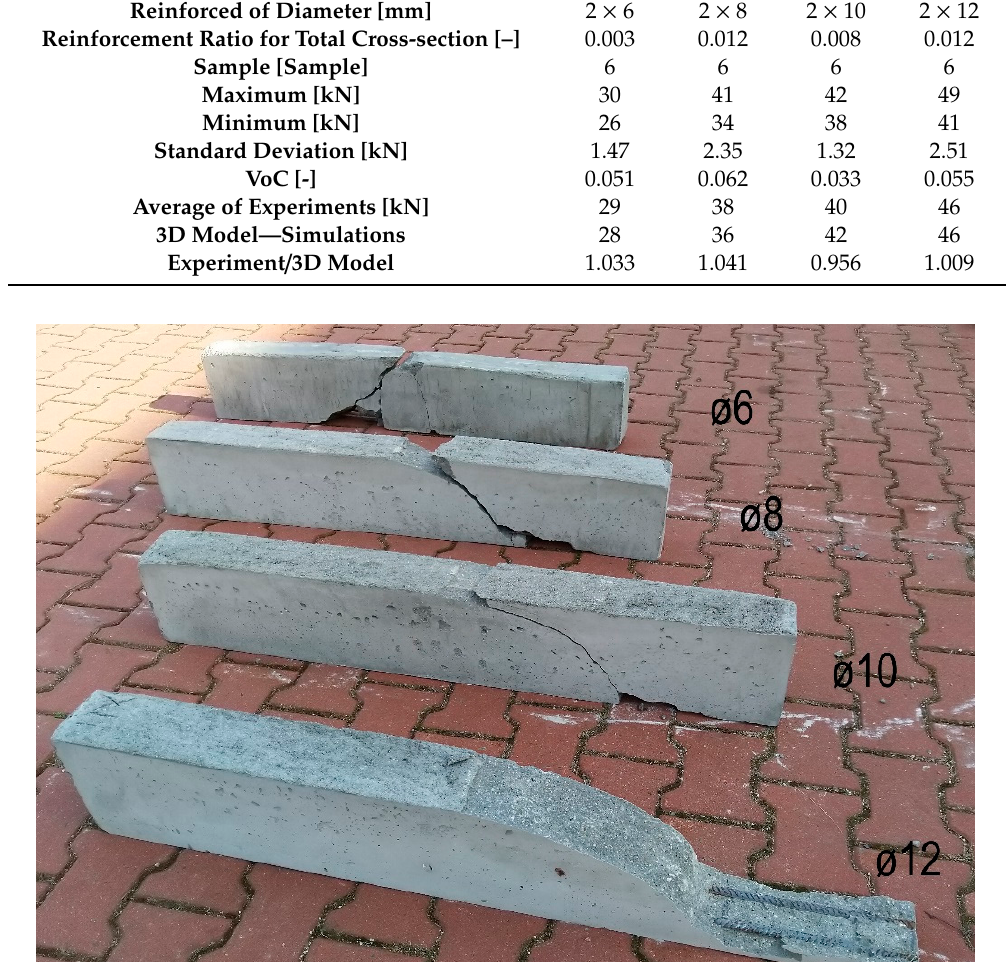
Table 10. Results of reinforced concrete beam without transverse reinforcement: Experiments—load capacity [kN].